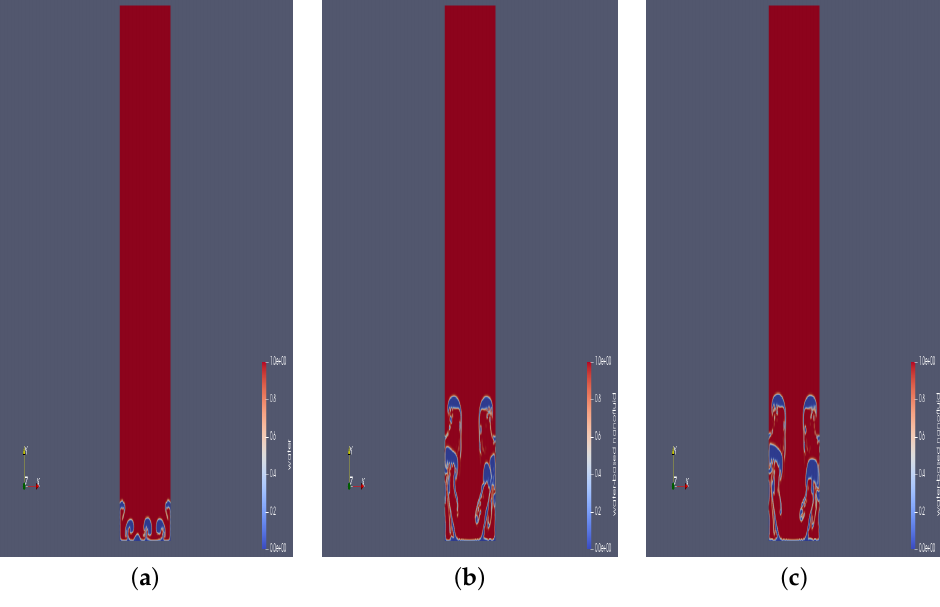
Figure 15. Solutions for multi-phase mixtures at time t = 10 s and ϕ = 0.1. ( a ) Water. ( b ) Water-Al 2 O 3 nanofluid. ( c ) Water-TiO 2 nanofluid.